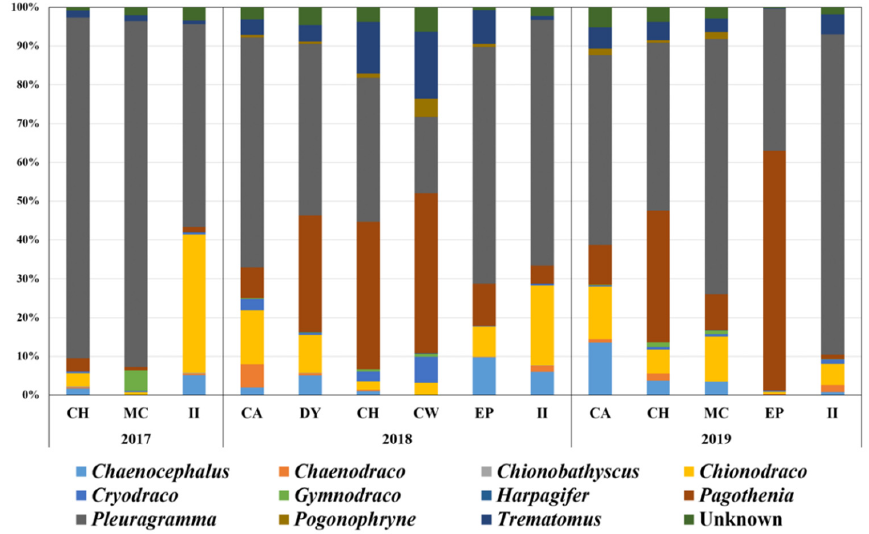
Figure 4. Prey items identified using miniFish metabarcoding. Graph displays proportions of prey items at the genus level at different sites by year. Table 4. Metabarcoding reads of fecal DNAs generated using miniFish primer set.